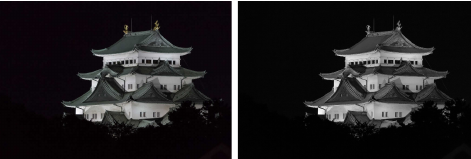
Figure 2. Input color and its grayscale images.